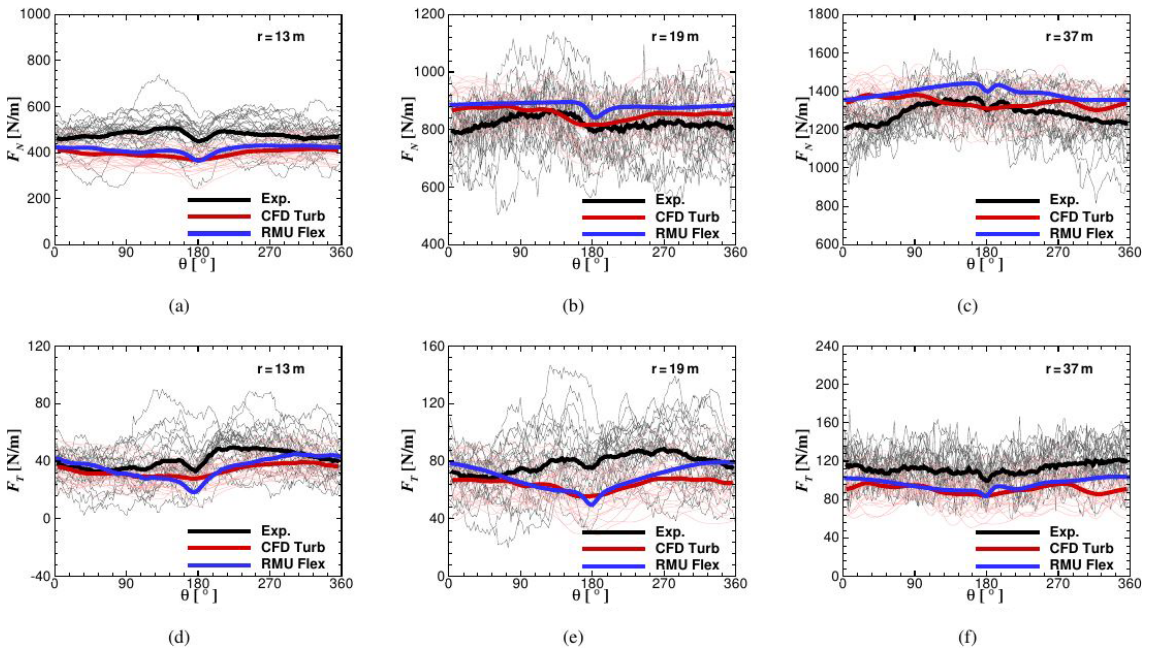
Figure 4. Comparison of experimental normal to the chord loads ( F N ) in (a) – (c) and tangential to the chord loads ( F T ) in (d) – (f) for three different radial sections ( r = 13, r = 19, r = 37m) over the blade. The blue line represents the full turbine with flexible blades. The red line represents a rigid rotor without tower but a turbulent inflow with the same TI as in the experiments. Thin grey and pink lines represent the data per revolution for the experiments and “CFD Turb”,